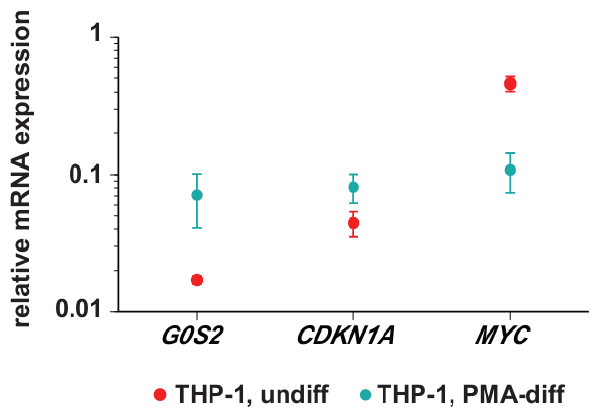
Figure S1. Basal mRNA expression of G0S2 , CDKN1A and MYC in monocyte- and macrophage-like cells. qPCR was performed to determine the relative basal expression of the genes G0S2 , CDKN1A and MYC (normalized to the reference genes B2M , GAPDH and HPRT1 ) in undifferentiated and PMA-differentiated THP-1 cells. The data points represent the means of three independent experiments and the bars indicate standard